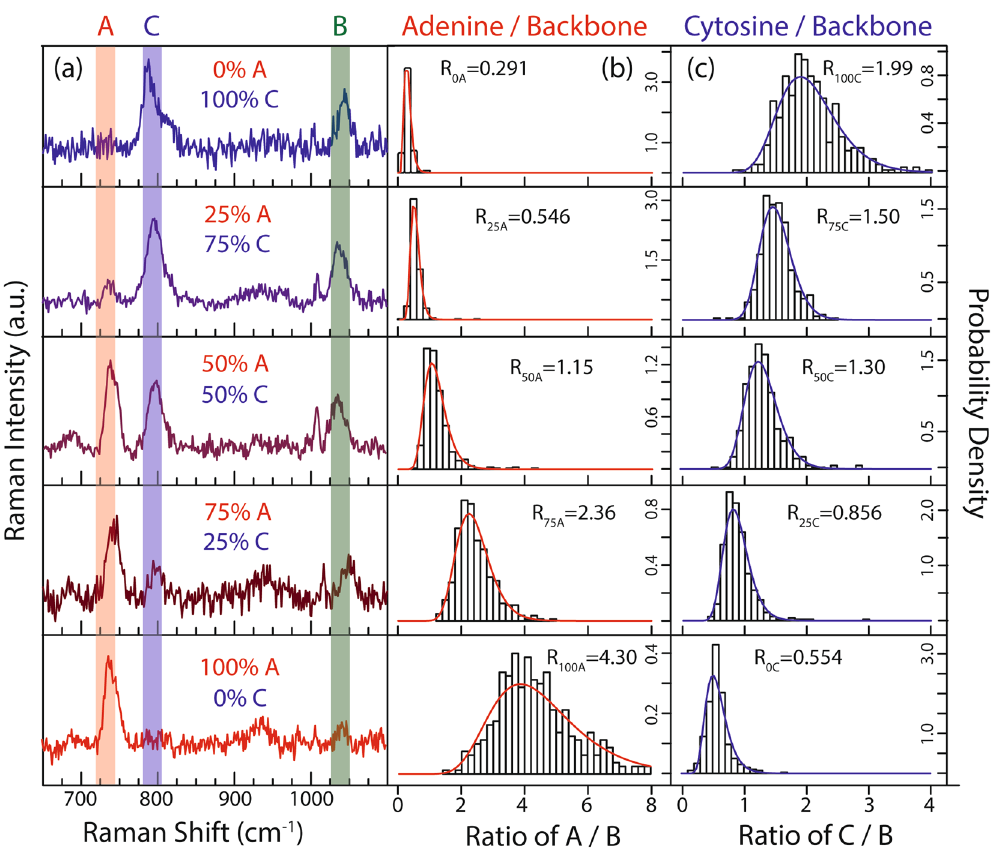
Figure 3. Raman spectra and corresponding probability distributions for the 5 standards. ( a ) Example Raman spectrum for each calibration standard with the adenine ring-breathing-mode (red), cytosine ring-breathing- mode (blue), and backbone mode (green) contained in the vertical shaded rectangle (see S2 for mode selection). ( b ) and ( c ) Probability density functions for the normalized ratios (A/B and C/B) for the 5 standards, showing the median of the lognormal distributions (R).